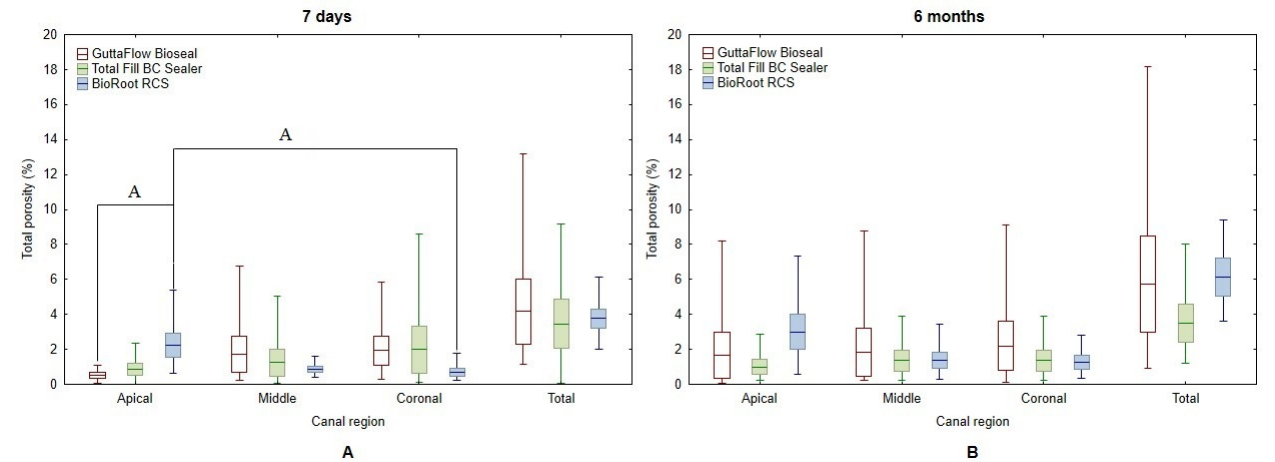
Figure 5. Regional and total porosity (%) of sealers in the root canal after 7 days ( A ) and 6 months